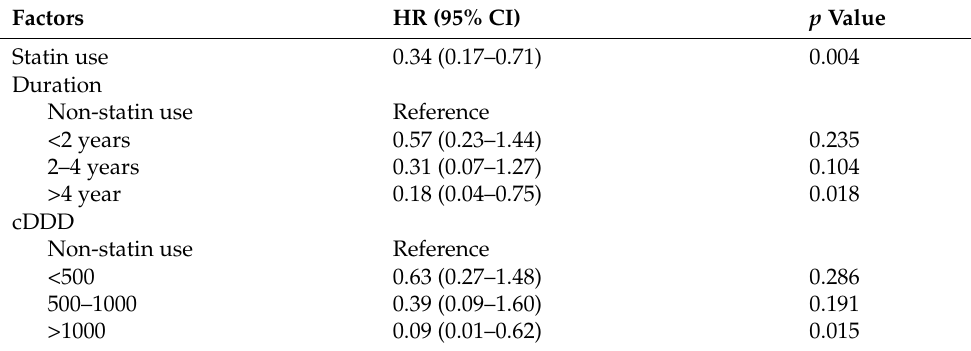
Table 4. Association between duration of use and dose of statins and gastric cancer in the propensity score-matched